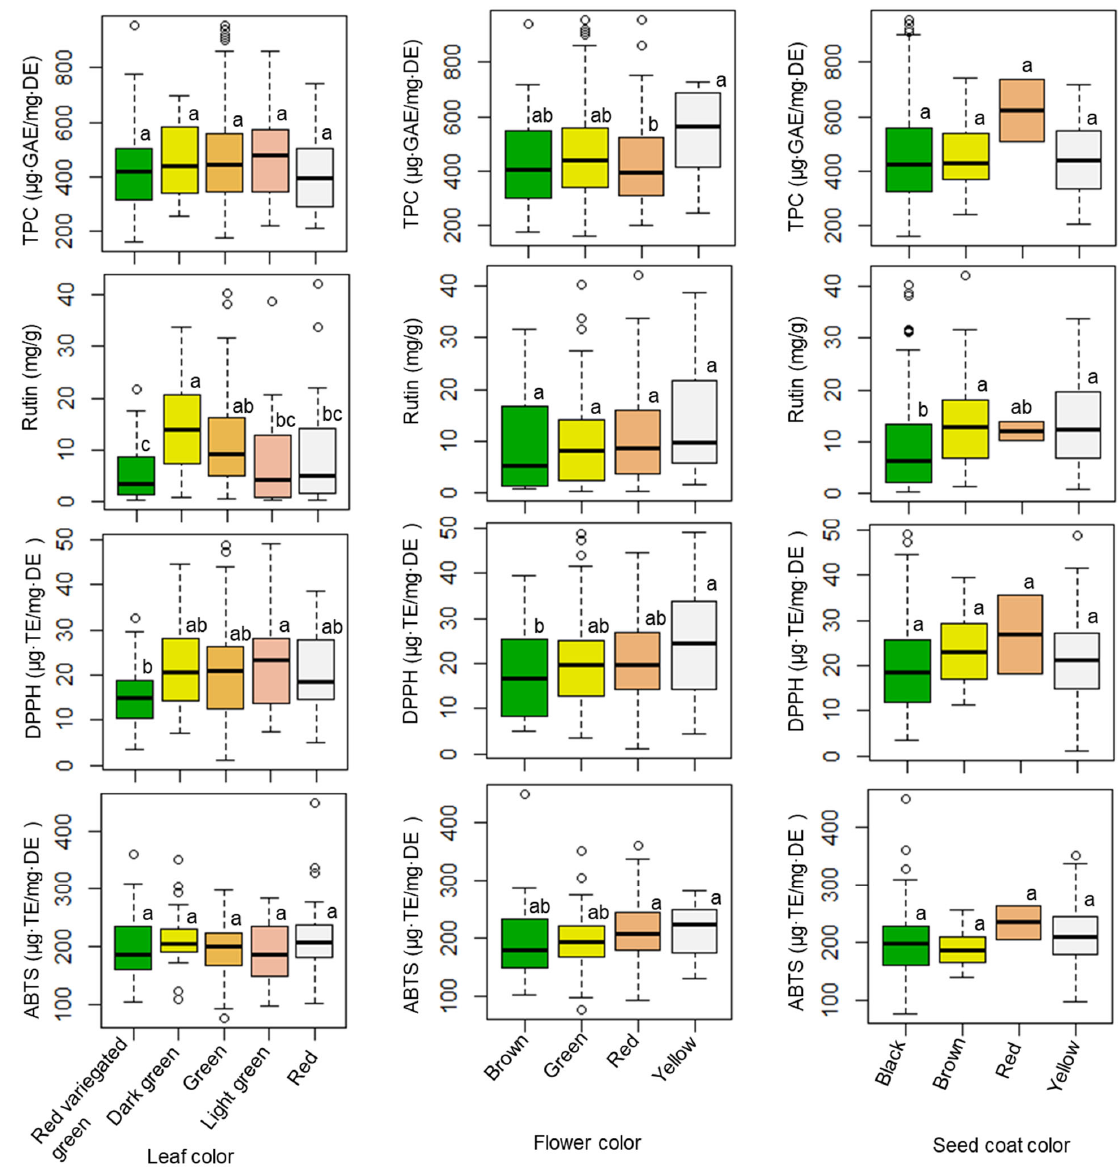
Figure 2. Variations of TPC, rutin, DPPH, and ABTS according to leaf, flower, and seed coat colors. Different letters indicate significant differences between groups ( p < 0.05). TPC = total phenolic content, DPPH = DPPH radical scavenging activity, ABTS = ABTS radical scavenging